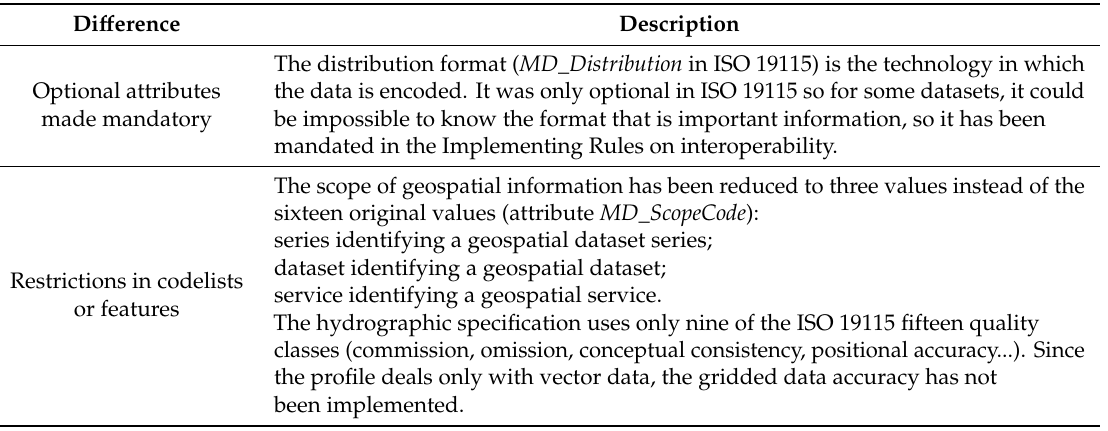
Table 11. Di ff erences of the INSPIRE profiles with the ISO 19115 base